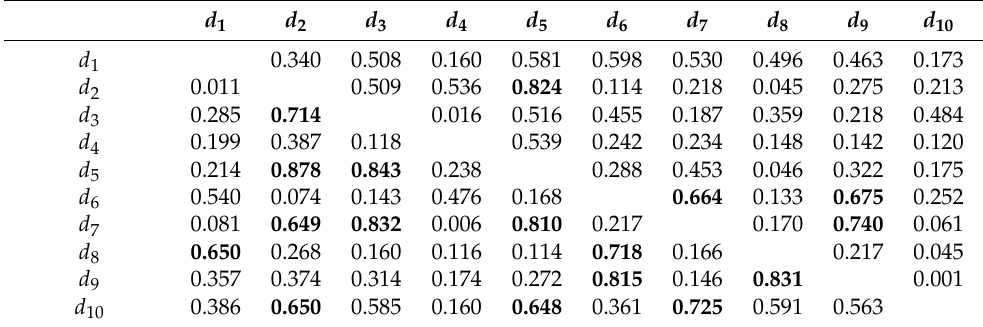
Table 2. Correlation coefficient between feature dimensions (absolute values); upper-right triangle submatrix: REVIVAL, lower-left triangle submatrix: